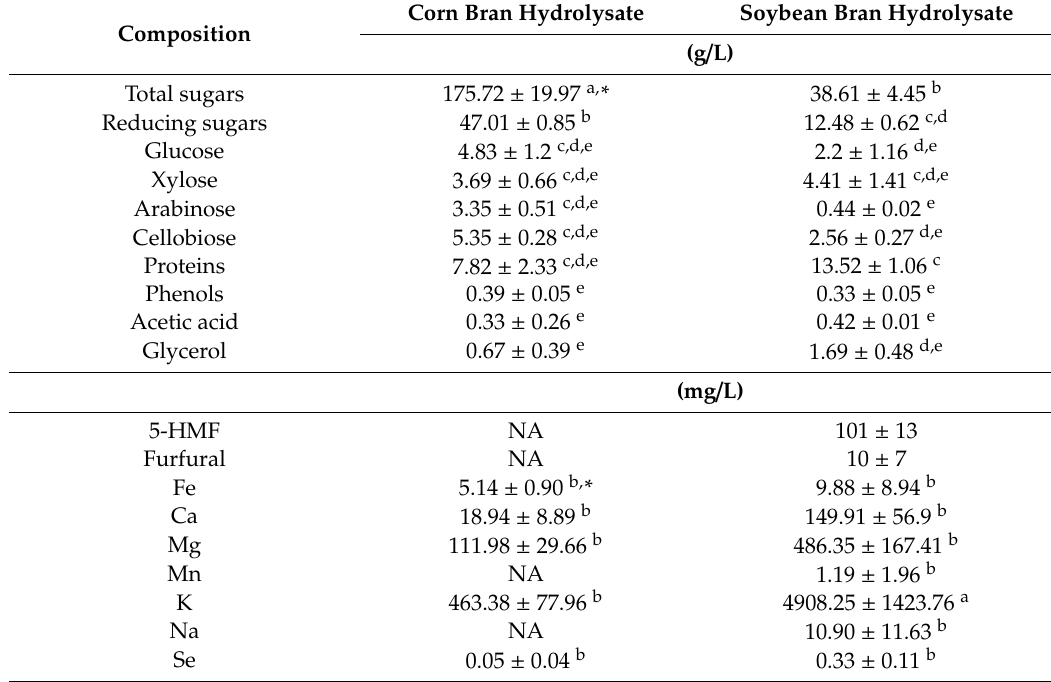
Table 1. Concentration of sugars, proteins, acetic acid, phenolic compounds, and sugar degradation products in corn bran, and soybean bran starchy acid